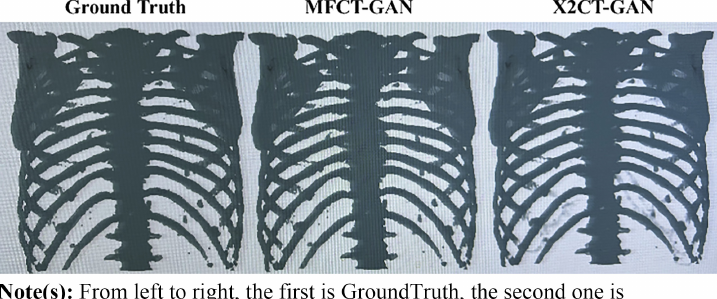
Figure 4. Volume rendering of bones from CT volumes